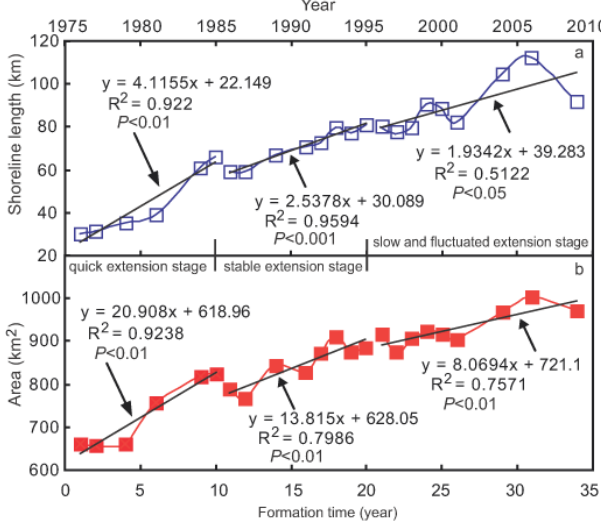
Fig. 5. The variations of shoreline length (a) and area (b) of the Yellow River Delta since